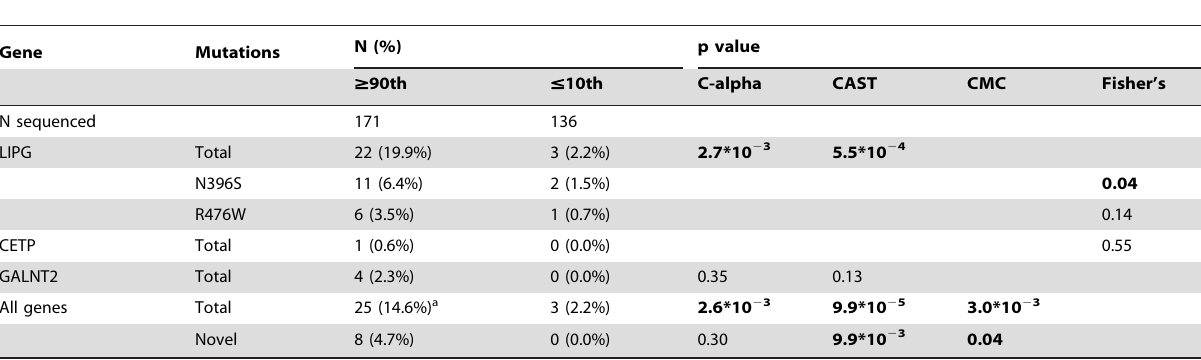
Table 2. Mutation frequencies and burden effects in